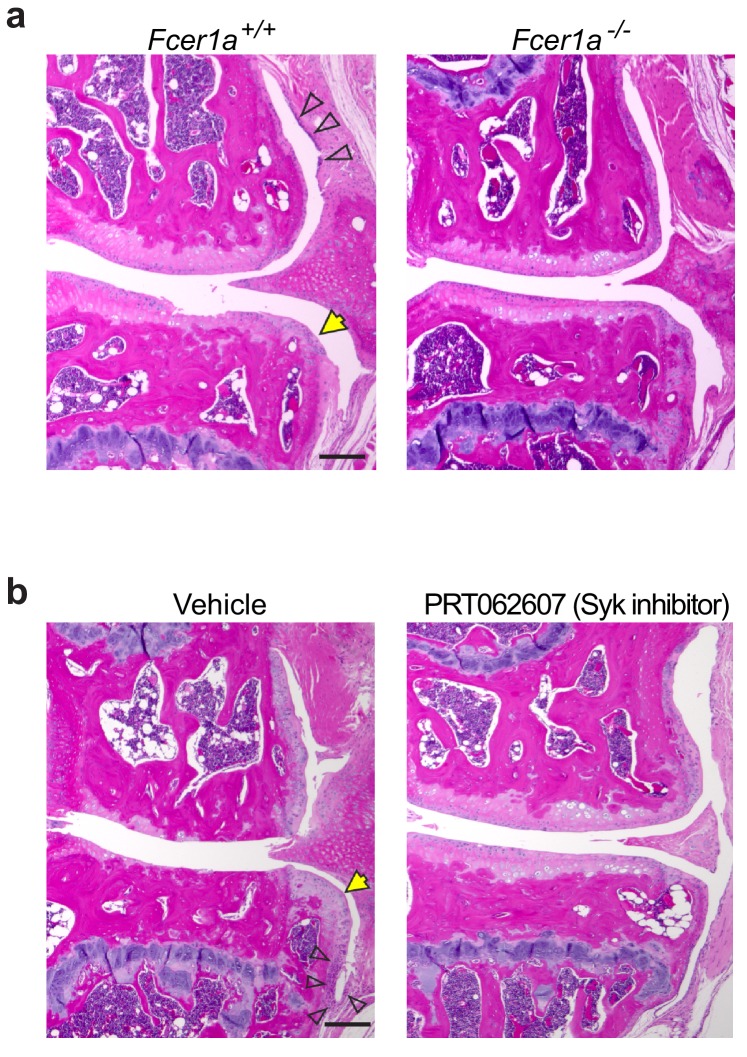
Deficiency in FceR1a or blockade of FcεRIα signaling in mice reduces synovitis and osteophyte formation following DMM.(a) Representative H&E-stained knee joint sections from Fcer1a-sufficient (Fcer1a+/+) and Fcer1a-deficient (Fcer1a-/-) mice 20 weeks after DMM surgery. (b) Representative H&E-stained knee joint sections from C57BL/6J mice treated orally with vehicle (PBS), or the Syk inhibitor PRT062607 (75 mg/Kg/day) every day for 12 weeks following DMM surgery. Osteophytes (yellow arrows) and synovial thickening (open arrows) were prominent in vehicle-treated controls, but not in the PRT062607-treated mice. Scale bars, 200μm.